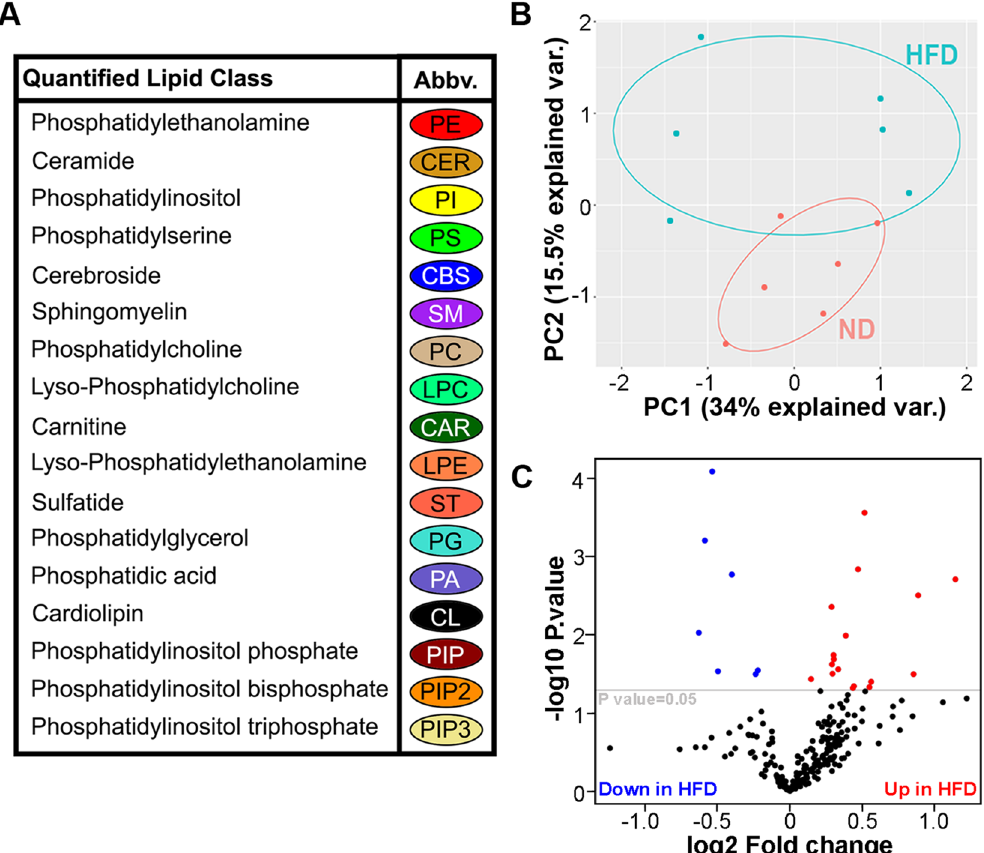
Figure 5. HFD significantly affects the brain lipidomic profiles. MDMS-SL was performed using cortices of APP23 mice. N = 3 male and 3 female mice per diet. ( A ) List of quantified lipid classes, their abbreviations and color association for correlation matrices. ( B ) Principal component analysis showing significant differences in brain lipidomics profiles between mice fed HFD and ND, with each point representing a single animal. ( C ) Volcano plot showing molecular species within major lipid classes significantly impacted by HFD in APP23 mice. Significant species are colored red for higher in HFD and blue for lower in